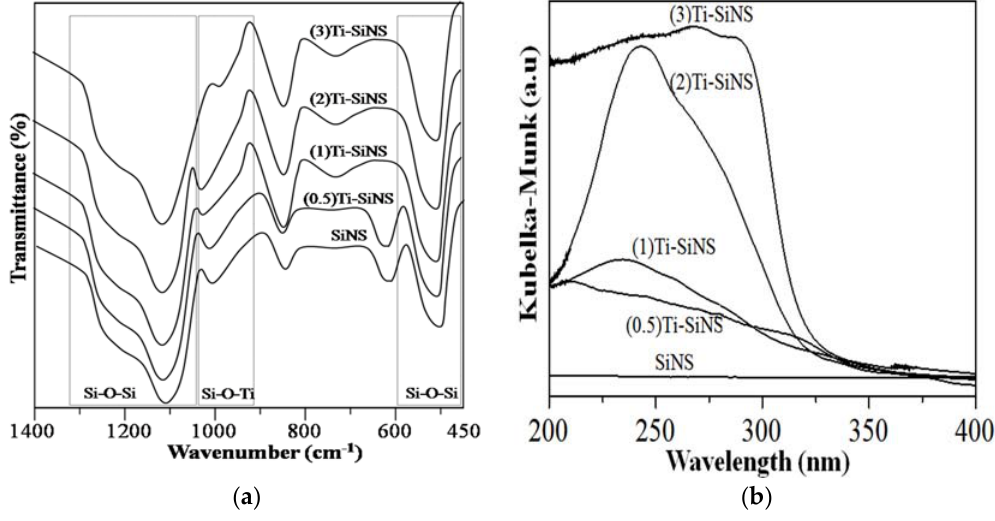
Figure 9. ( a ) FTIR spectra; and ( b ) DR UV ‐ Vis spectra for SiNS, (0.5), (1), (2), and (3)Ti ‐ SiNS. Table 1. Energy dispersive X ‐ ray ( EDX) analysis for element composition in (1) nanostructured titania ‐ silica (Ti ‐ SiNS).